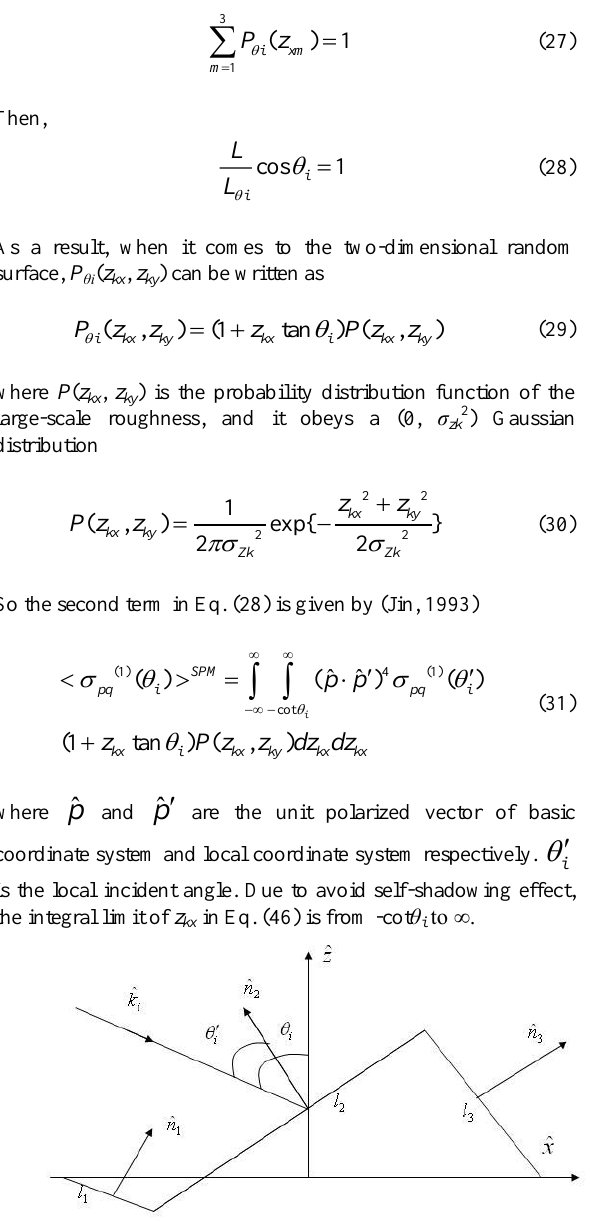
Fig. 3 The probability distribution of gradient in geometric explanation (Jin, 1993) 4 VALIDATION The AIEM, which is the improvement of IEM, was adopted to verify the MTSM in this paper. With the widest range of applicability, the AIEM is the most popular method used in calculating the surface scattering in contrast to other models. In AIEM, the single scattering term is given